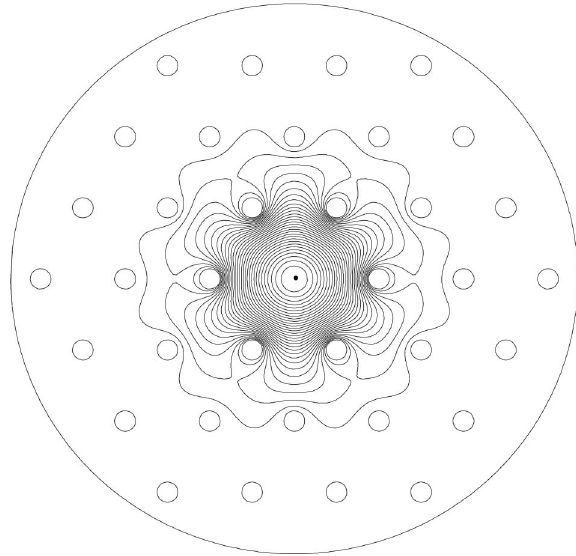
FIG. 1. Cross section of the PBG cavity geometry. The cavity is formed by metal rod lattice with a defect in the center and is surrounded by a metal wall. The contours of constant E field are also plotted.